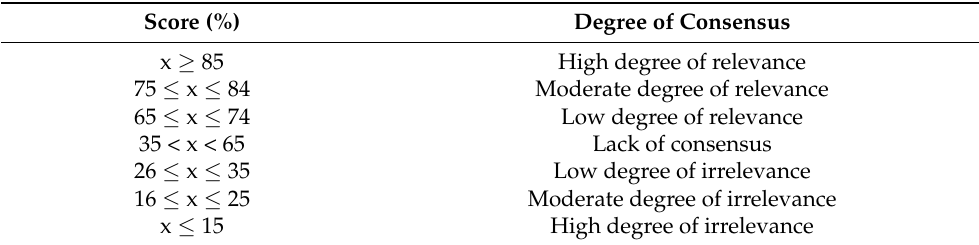
Table 2. Consensus scale for the relevance of identified technical solutions. Score (%) Degree of Consensus x ≥ 85 High degree of